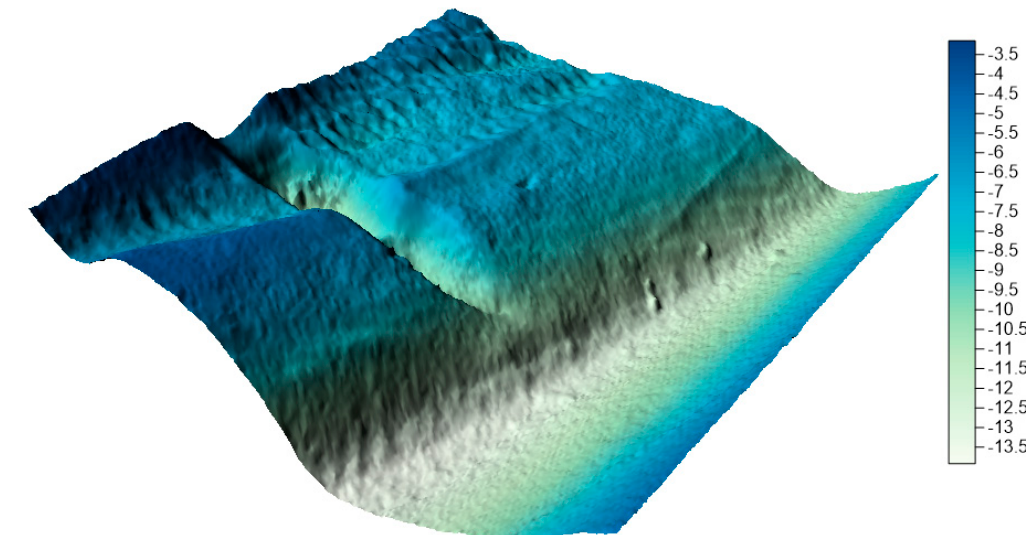
Sensors 2020 , 20 , x FOR PEER REVIEW Figure 14. Reference surface for the Inski canal area. Figure 14. Reference surface for the Inski canal area.